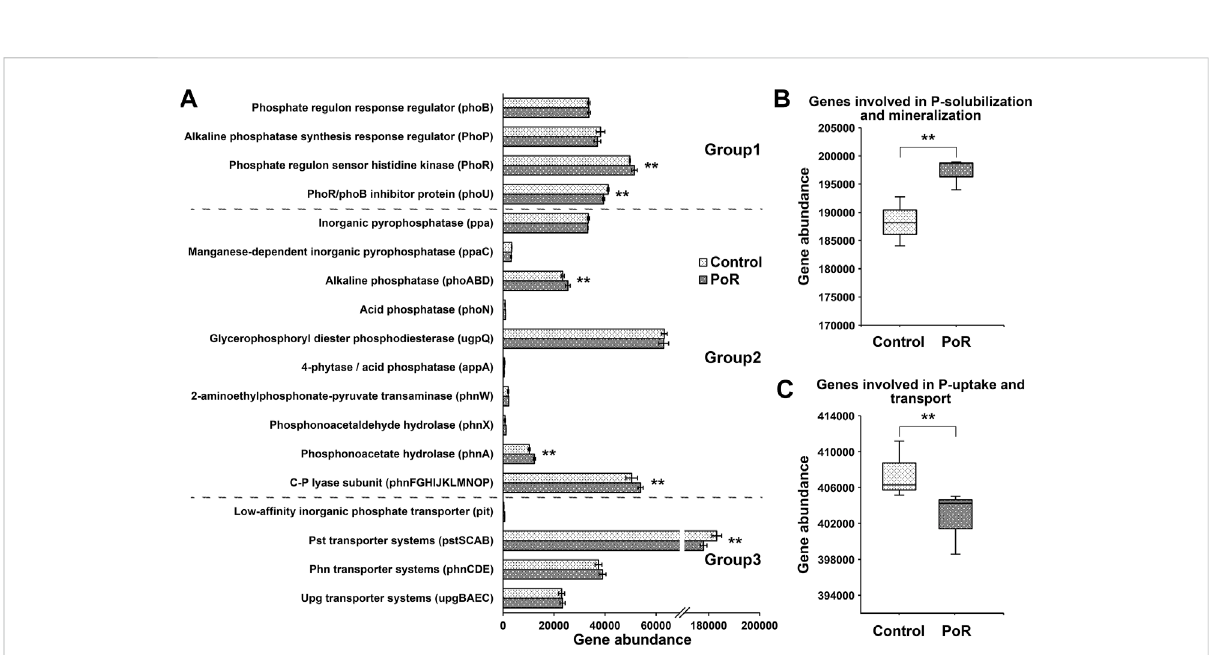
FIGURE 2 TheabundanceofgenesinvolvedinPtransformationinsoilshavingundergonedifferenttreatments (A) .Group1:genescodingforregulationof the P-starvation response; Group 2: genes coding for inorganic P-solubilization and organic P-mineralization; Group 3: genes coding for P-uptake and transport. Total abundance of genes involved in P-solubilization and mineralization (B) and P-uptake and transport (C) . ** indicates a signi fi cant difference between PoR and control (Kruskal – Wallis rank sum test, p <